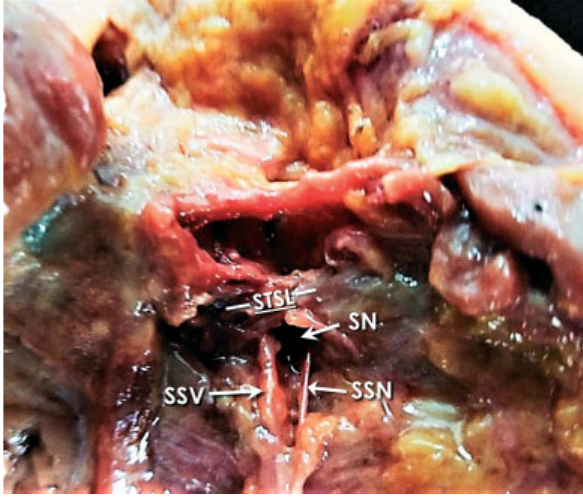
Fig. 3 Type-II content of the SN according to the classi fi cation used (only the nerve through the notch). SN, suprascapular notch; SSN, suprascapular nerve; SSV, suprascapular vein; STSL, superior trans- verse scapular